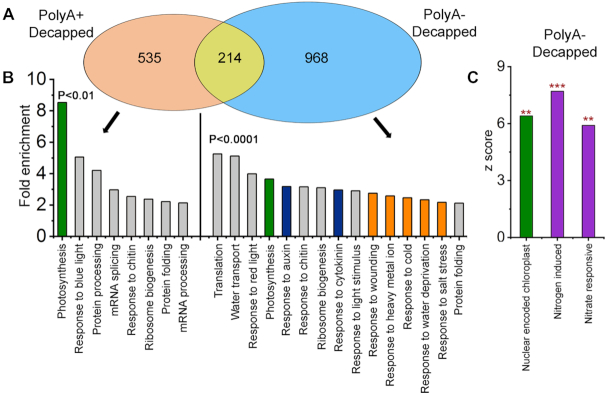
Decapped XRN4 substrates are over-represented for categories associated with photosynthesis, stress and hormone responses. (A) Transcripts overaccumulating decapped intermediates in both xrn4–5 and xrn4–6 were identified from the overlap data in Figure 3B. Weighted Venn diagrams designate these as decapped polyA+ (polyadenylated) and polyA- (deadenylated) XRN4 substrates as discussed in the text. (B) Gene-ontology (GO) enrichment categories of decapped XRN4 substrates. Highlighted are significant GO functions associated with photosynthesis (green), abiotic stimulus/responses (orange), hormone responses (blue) and other categories (gray). Only 15 most significant terms are presented for polyA- and the rest are listed in Supplementary Table S5 (PARE). (C) Nitrogen (N) responsive and NEC transcripts are over-represented among XRN4 substrates. Overlap significance between decapped XRN4 substrates (**, P < 0.01; ***, P < 0.001) and transcripts from different datasets was evaluated using the GeneSect program (Supplementary Table S4).